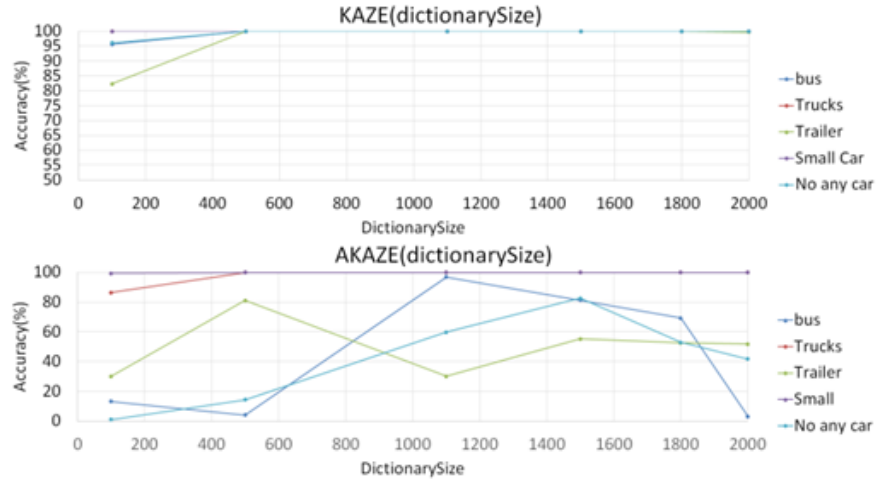
Figure 12. KAZE/AKAZE BoF Classification Accuracy vs. Dictionary Size.